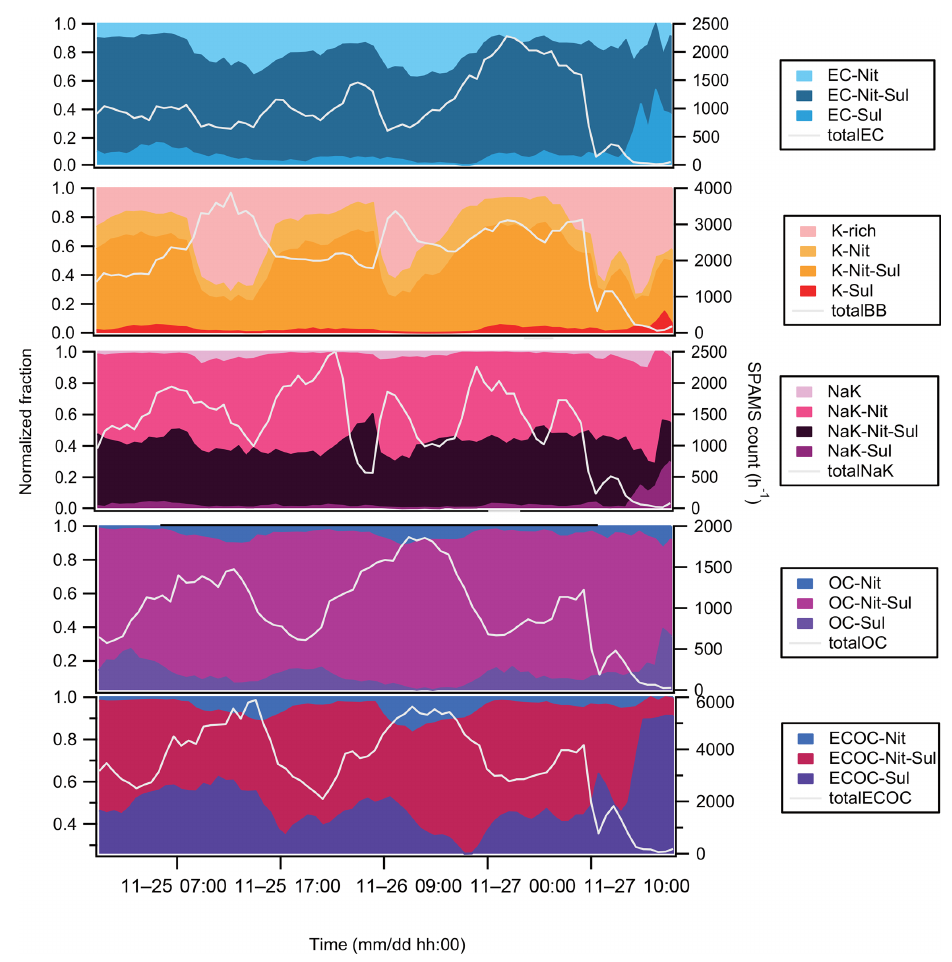
Figure 7. Normalized time trends of number fractions of particle types (left) and hourly counts of particle families (EC, BB, NaK, OC, and ECOC; right) during Pollution Event 4 (E4) at